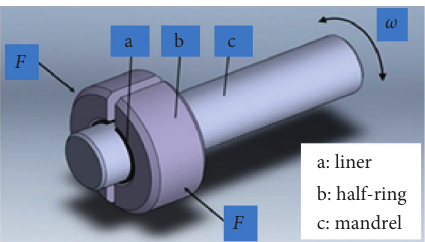
Figure 1: Friction pair for life